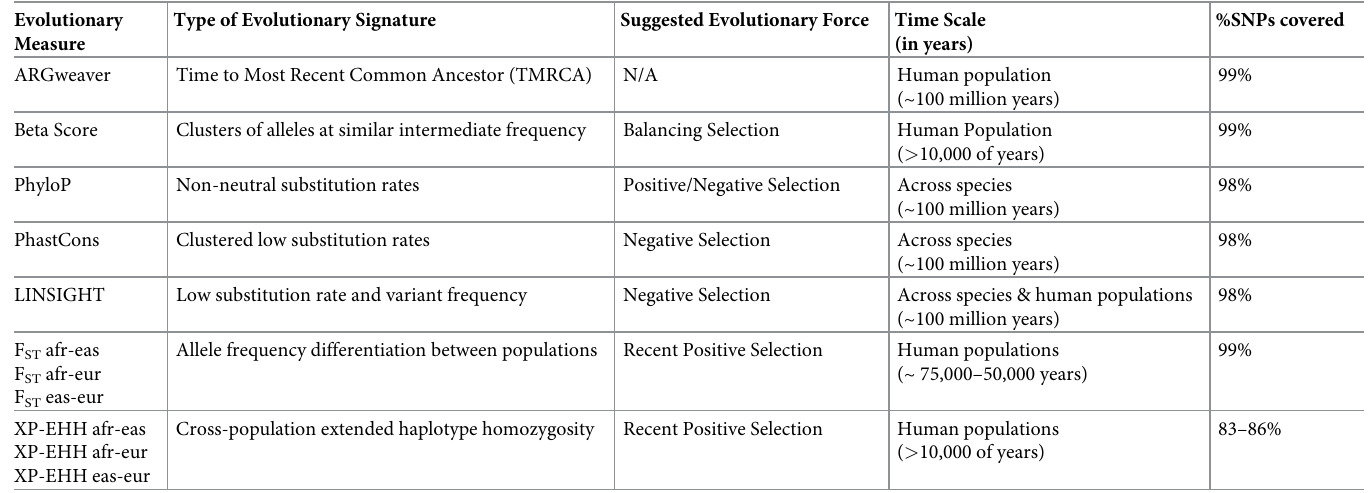
Table 1. Evolutionary measures used to quantify trait-associated regions. For each evolutionary measure (rows), the sequence pattern, type of evolutionary force sug- gested, and the corresponding time scale is given. Multiple selective and non-selective forces can shape these patterns. “%SNPs covered” is the proportion of SNPs from 1000 Genomes Phase III after quality control (n = 9,535,059) that have an annotation for the given evolutionary measure. For F ST and XP-EHH, we used the following 1000 genomes superpopulation comparisons: afr-eas, afr-eur, eas-eur. XP-EHH: cross-population extended haplotype homozygosity (EHH). TMRCA: time to most recent common ancestor derived from ARGweaver.